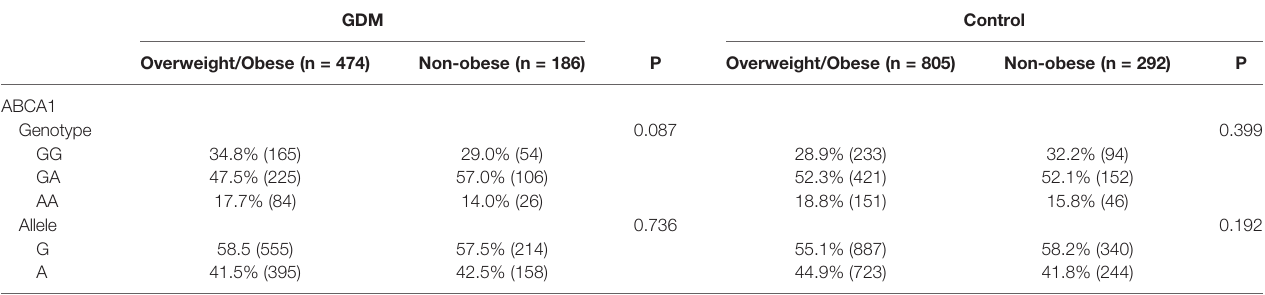
TABLE 3 | Genotype and allele frequency for the rs2230806 SNP of the ABCA1 gene in women with GDM and control subjects divided into overweight/obese and nonobese